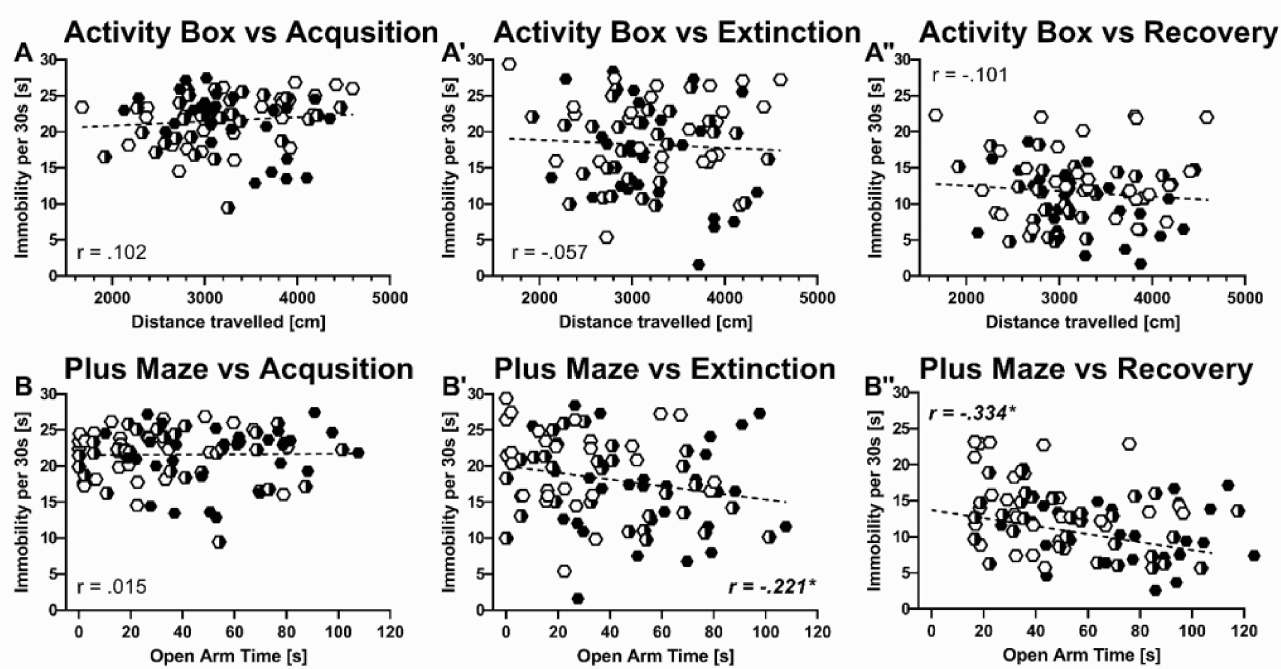
Figure 10. Correlation: novelty-seeking, anxiety-related behavior, and immobility. Duration of immobility during acqui- sition, extinction, and recovery, in relation to novelty-seeking in the activity box ( A – A” ) and anxiety-like behavior in the elevated plus maze ( B – B” ). Depicted are SERT +/+ (black diamond), SERT +/ − (black-white diamond), and SERT − / − (white diamond) rats. N = 29 SERT +/+ (15 female, 14 male), 30 SERT +/ − (15 female, 15 male), 28 SERT − / − (14 female, 14 male) rats, except activity box (see materials and methods for details). Data are presented as individual values and correlation coefficients. Statistical significance ( p < 0.05) of correlation coefficient is indicated in bold and